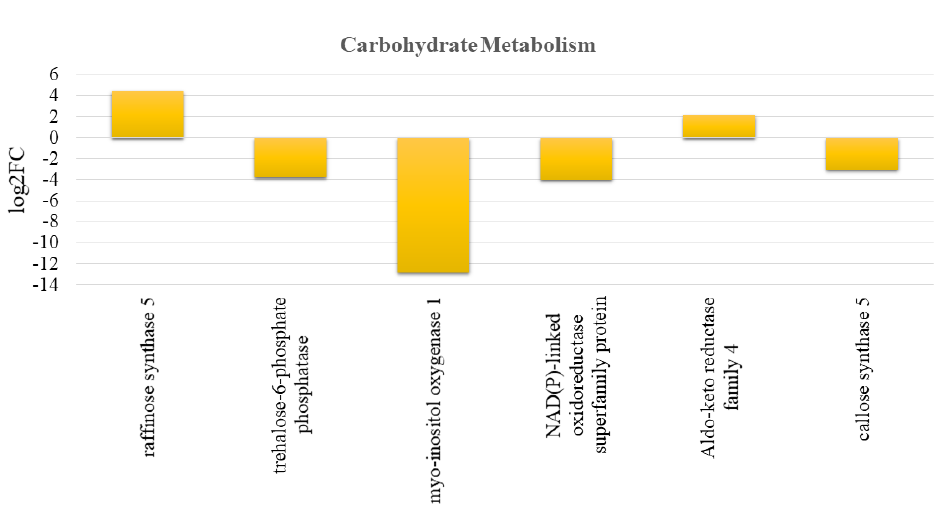
Figure 4. The figure shows the carbohydrate metabolism and mobilization pathway in pistachio among the June “OFF” vs. June “ON” fruits comparison. The y-axis represents the value of log2 fold change. The bar indicates the effects on carbohydrate levels driven by differential expression of different CHO metabolism genes.